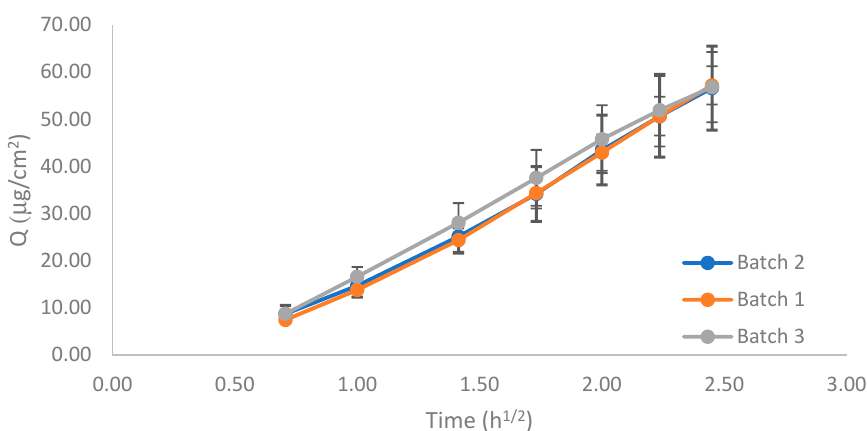
Figure 8. Release profile of the three 0.025% w/w capsaicin emulsion batches. Table 7. The 90% confidence intervals (CIs) of the release parameters (released amount of capsaicin at 6 h (Q 6h ) and release constant (K)) of three 0.025% w / w capsaicin emulsion batches. SD: standard deviation. Batches